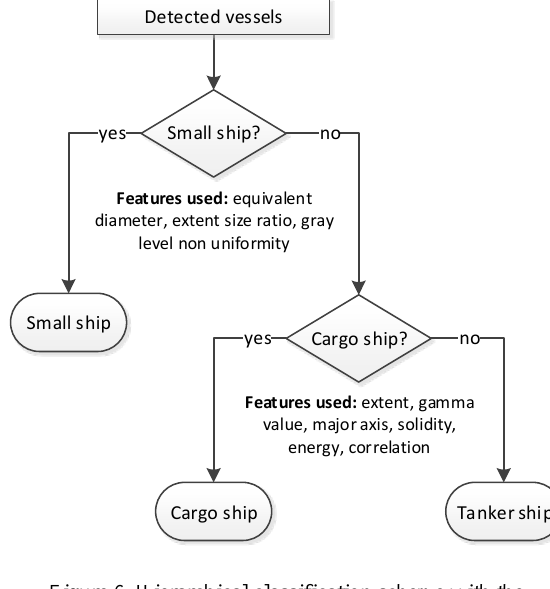
Figure 6. Hierarchical classification scheme with the dominant features used in every stage.